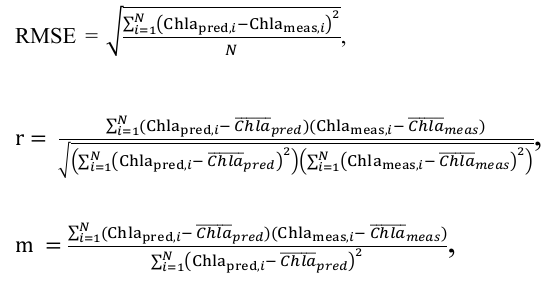
Table 2 . The predictor(s) of models.